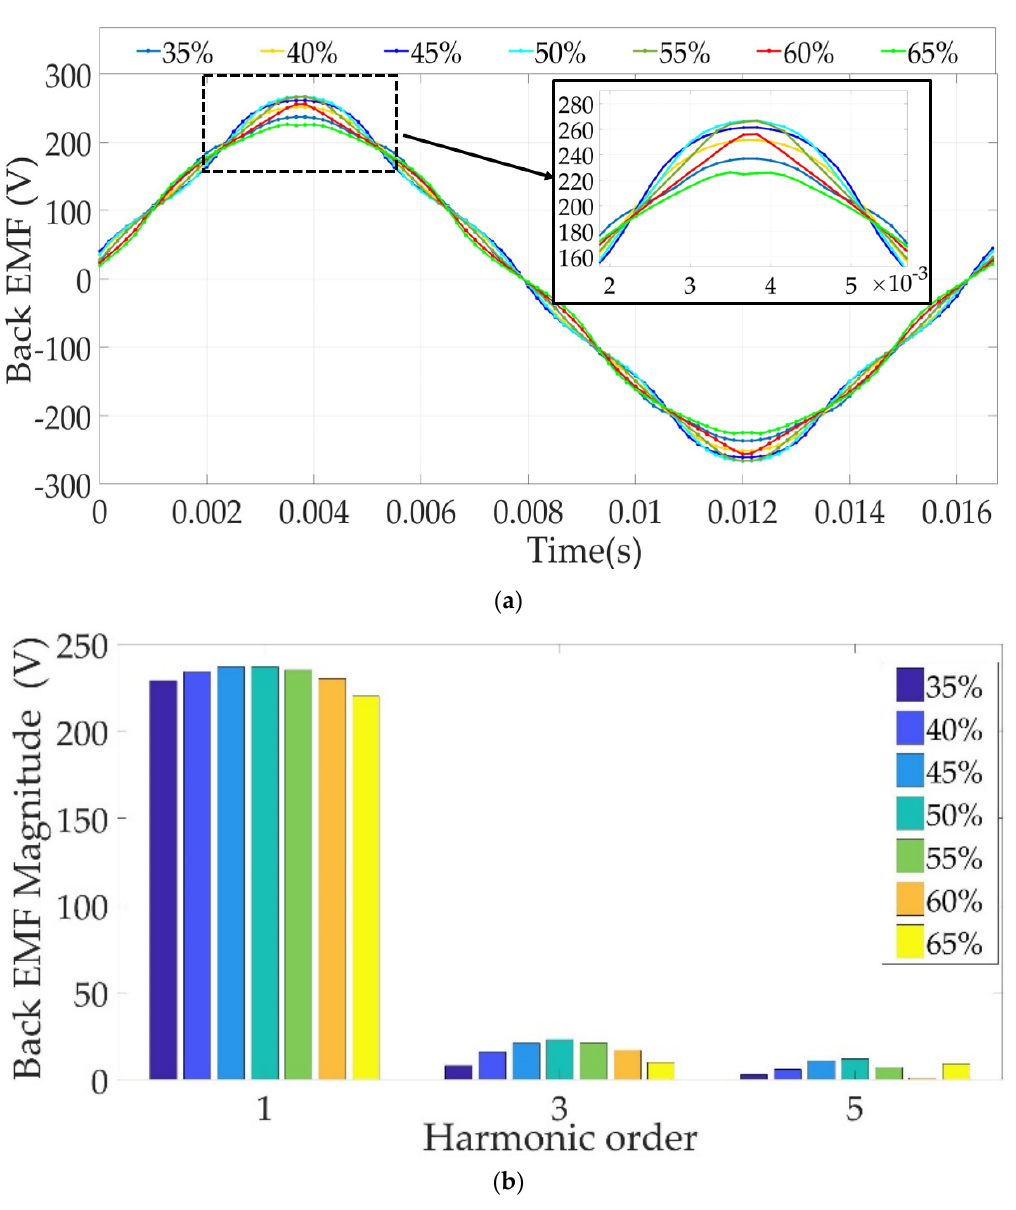
Figure 9. ( a ) Back-EMF vs. time for different ratios β ( α = 0%). ( b ) Magnitude of the first 3 harmonics of the back-EMF for different ratios β ( α = 0%).